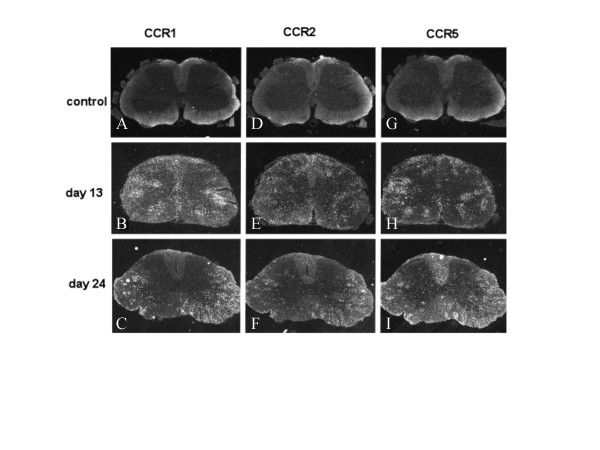
Distribution of CCR1, CCR2, CCR5 mRNA expressing cells at different time points in the spinal cord of MOG-EAE rats. In situ hybridization with 35S-labelled antisense cRNA probes encoding rat CCR1, CCR2 and CCR5 to coronal sections from the lumbar segment of spinal cord of rats with MOG-EAE. Cells expressing CCR1, CCR2 and CCR5 mRNA are visualized by dark field illumination of the photo emulsion-dipped slides. Intensive signals for CCR1 and CCR5 mRNA, and moderate signals for CCR2 mRNA, were detected on days 13 (B, E, H) and 24 (C, F, I) post immunization. No signal for CCR1, CCR2 or CCR5 mRNA was detected in healthy control animals (A, D, G). No signal was detected in control sections hybridized with sense probe (not shown).